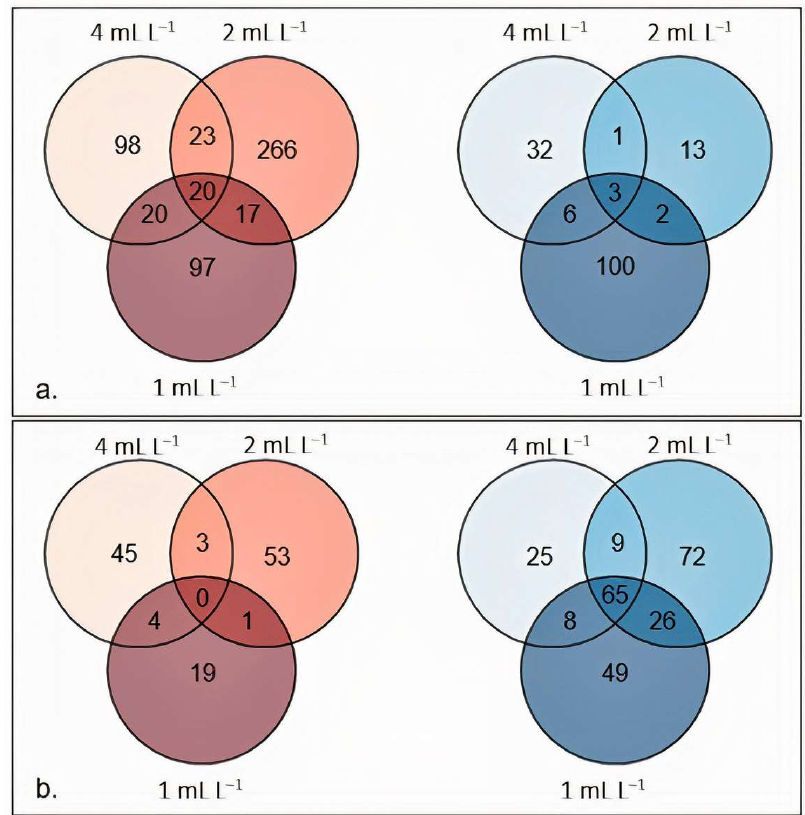
Figure 1. Number of DEGs specific and unique for each dilution. Upregulated (red) and downregulated (blue) genes at the three BSE concentrations with respect to the control 24 h after treatment ( a ) and 48 h after treatment ( b ).